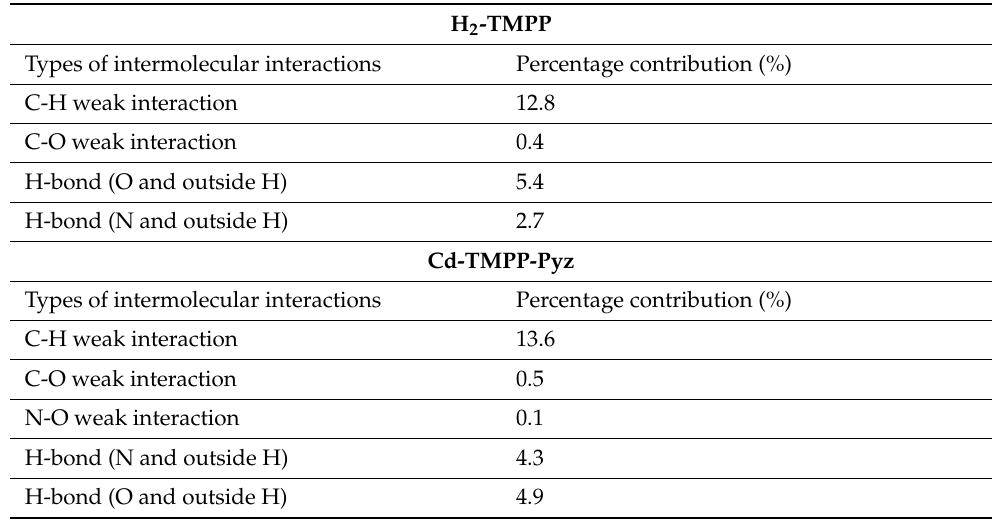
Figure 8. 2D HSA plot for the C-H··· π , C···O, N···O, C-H···N-H and O···H hydrogen bonding interactions for H 2 -TMPP ( a ) and Cd-TMPP-Pyz ( b ). Table 2. Percentage contribution of each C-H··· π , C···O, N···O, C-H···N-H and O···H hydrogen bonding HSA-based intermolecular interactions for H 2 -TMPP and [Cd(TMPP)(Pyz)]. H 2 -TMPP